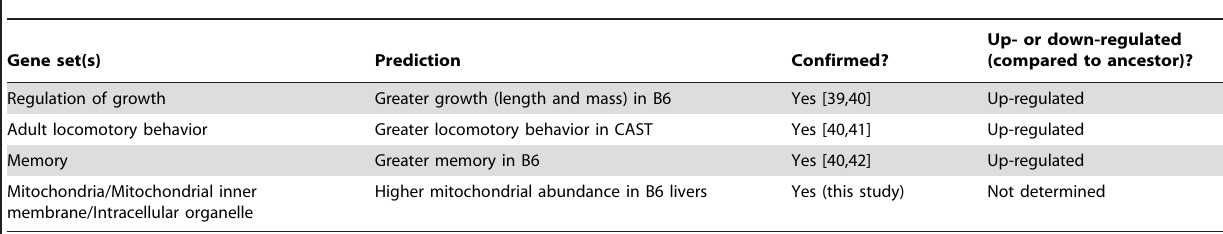
Table 2. Phenotype predictions and